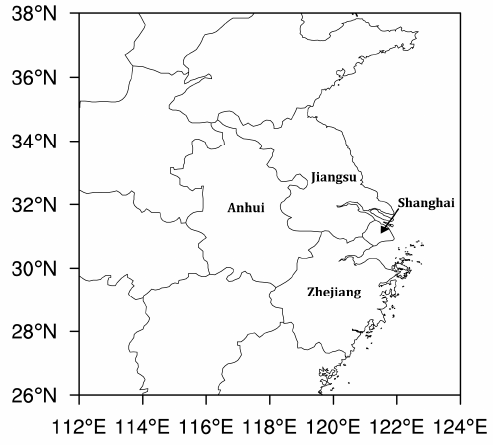
Figure 2. Horizontal extent of the simulated domain.